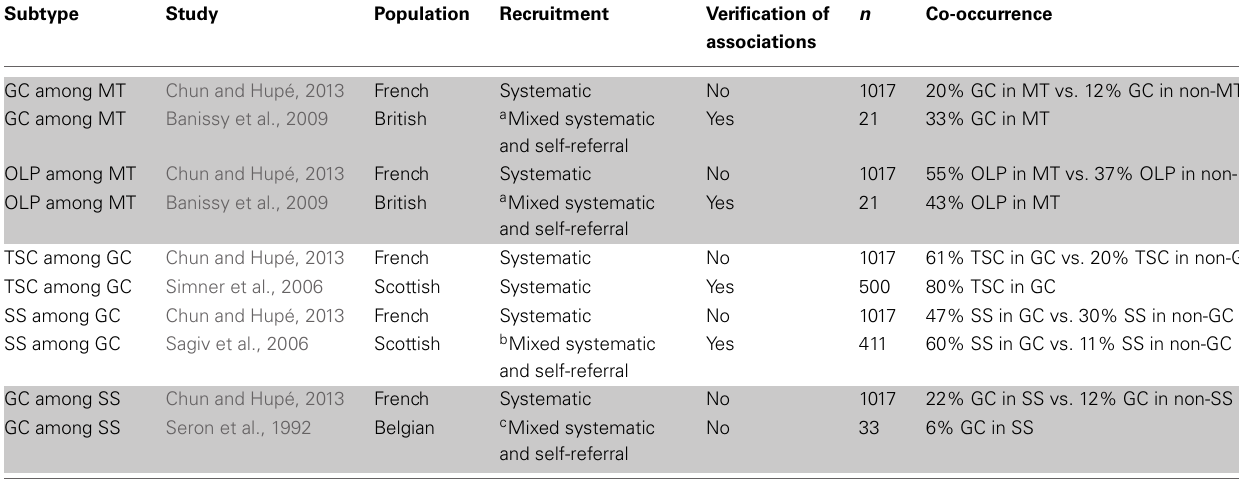
Table 4 | Co-occurrence